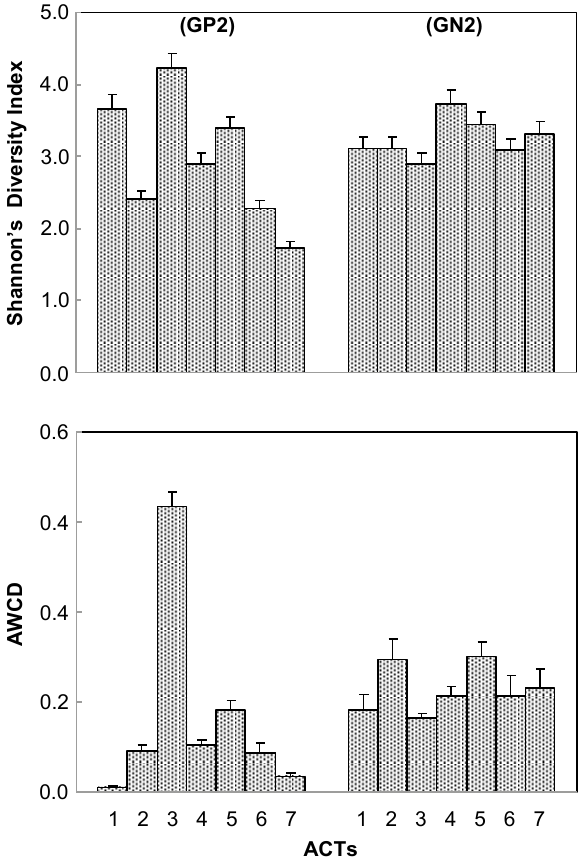
Figure 1. Shannon’s Diversity Index (H’) and Average Well Colour Development (AWCD) calculated for different aerated compost teas (ACTs) from GP2 and GN2 carbon substrate use profiles, measured after 120 h by standardized 590 nm